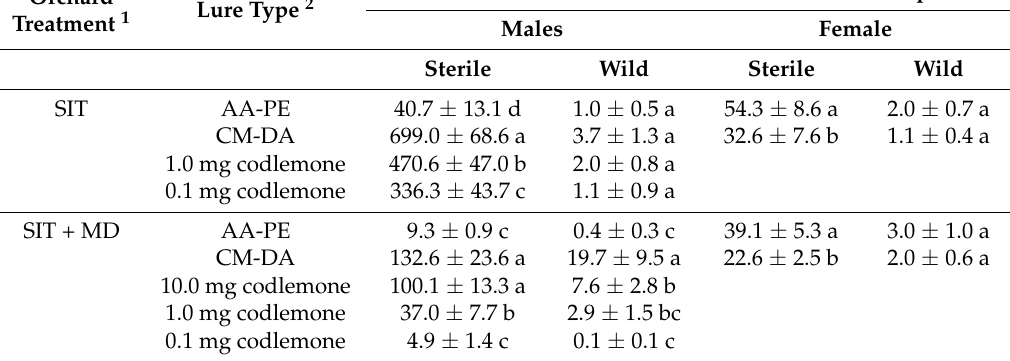
Table 3. Comparative seasonal catches of sterile and wild codling moths in white delta traps baited with various lures in apple orchards under management by sterile insect treatment (SIT) alone or a combination of SIT and pheromone mating-disruption